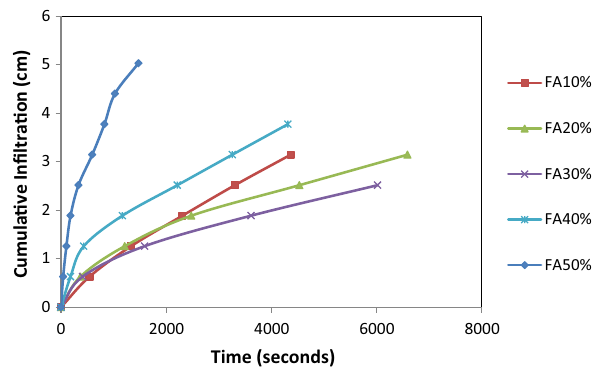
Fig. 4 Cumulative infiltration versus time for varying fly ash at 5% moisture content